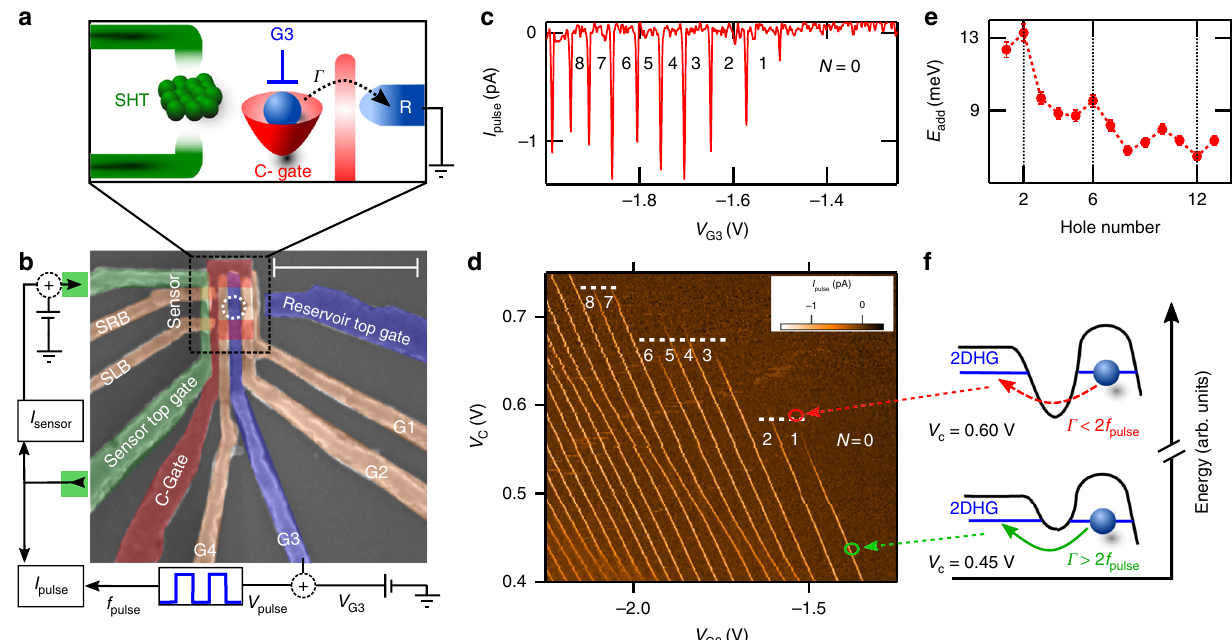
Fig. 1 Silicon quantum dot with a charge sensor, capable of reaching the last hole. a Schematic of the device concept. The device consists of a quantum dot coupled to a single reservoir (R), with an adjacent single-hole transistor (SHT) charge sensor. The tunnel rate between the dot and reservoir ( Γ ) can be tuned using the C-gate voltage ( V C ), and the dot occupation can be controlled with G3-gate voltage ( V G3 ). b False-colored scanning electron microscope image of an identical device, with the measurement schematic. The scale bar is 500 nm. c Depletion of the last 10 holes in the quantum dot, showing the V pulse induced signal on the charge sensor measured at V C = 0.47 V. d Charge stability diagram, showing the number of holes on the dot as a function of the con fi ning gate (C-gate) and pulse gate (G3) potentials. The horizontal white lines highlight the disappearance of the charge transition signals in distinct groupings, indicating shell fi lling. Measurements performed for V pulse = 3 mV and f pulse = 333 Hz. A slight bending in the lines in the vicinity of V G3 = − 2 V, V C = 0.55 V is due to coupling to nearby con fi ned charge. e The hole addition energy extracted from d , showing peaks at N = 2 and 6 consistent with shell fi lling. The error bars result from the standard error in the mean of 20 measurements over a range of V C . f Schematic diagram depicting the change in the tunnel barrier height between the V C and V G3 con fi gurations indicated by the green and red circle in d . The tunnel rate, Γ , between the dot and the 2D hole gas (2DHG) is in fl uenced by changing V C , causing the charge transition signals to disappear when the tunnel time becomes comparable to the period of the pulses applied to G3. See Methods section for additional experimental